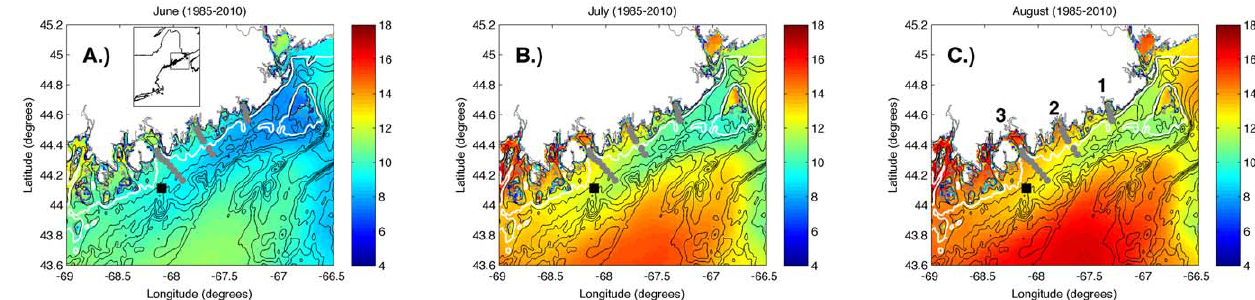
Figure 1. Climatological sea surface temperature ( 6 C) of study area for (A.) June, (B.) July, and (C.) August. The gray circles indicate the locations of the CTD and larval sampling stations on the three transects. The numbers in (C.) indicate the inshore end of each transect. Transect # 1 is farthest upshelf (northeast). Transect # 3 is farthest downshelf (southwest). The white line represents the 75 m isobath. The black square indicates the location of buoy EB44034, which was the source of wind